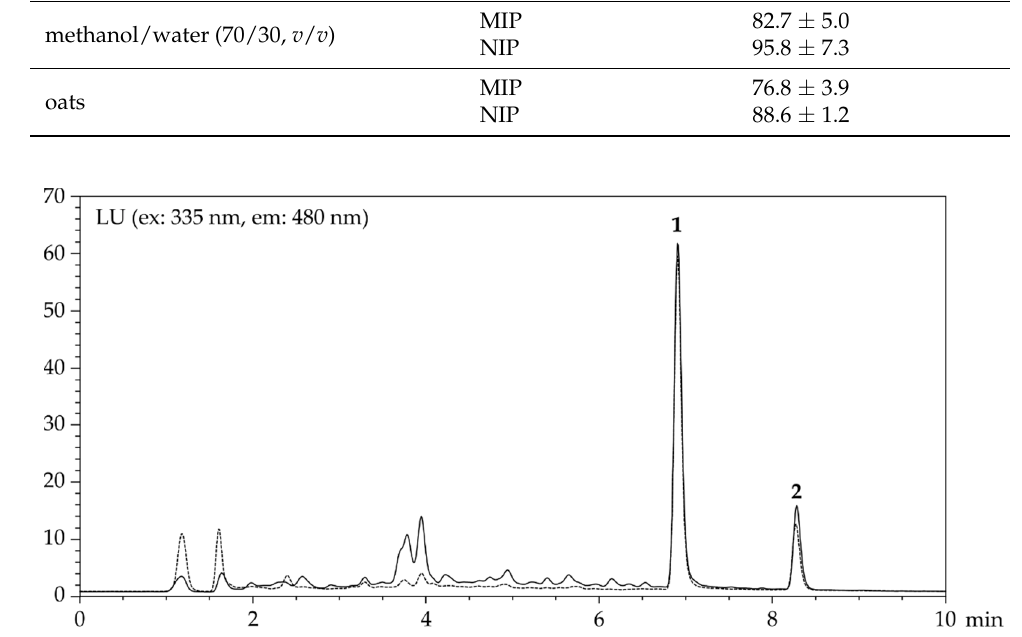
Figure 4. Chromatograms of CIT ( 1 , 400 ng/mL) and OTA ( 2 , 30 ng/mL) of oats spiked before (—) and after (---) MISPE (see Materials and Methods for details).